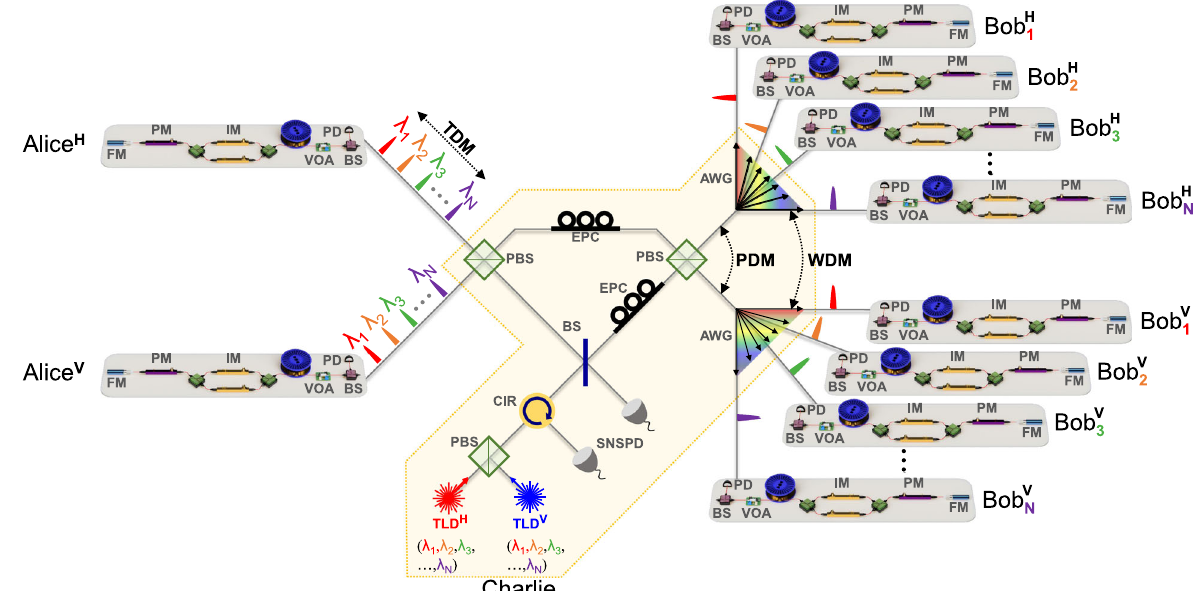
Fig. 1 2 × N plug-and-play (PnP) twin- fi eld quantum key distribution (TF-QKD) network scheme. Three multiplexing methods of polarization, wavelength, and time division multiplexing (PDM-WDM-TDM) are used to con fi gure a 2 × N network. Alice and Bob identically consist of simple devices for synchronization and state preparation, while expensive and complicated devices such as lasers and SPDs are placed in Charlie. The abbreviation de fi nitions are as follows. TLD wavelength-tunable laser driver, PBS polarization beamsplitter, CIR circulator, BS beamsplitter, SNSPD superconducting nano-wire single-photon detector, EPC electrical polarization controller, AWG arrayed waveguide grating, PD photodiode, VOA variable optical attenuator, IM intensity modulator, PM phase modulator, FM Faraday rotator